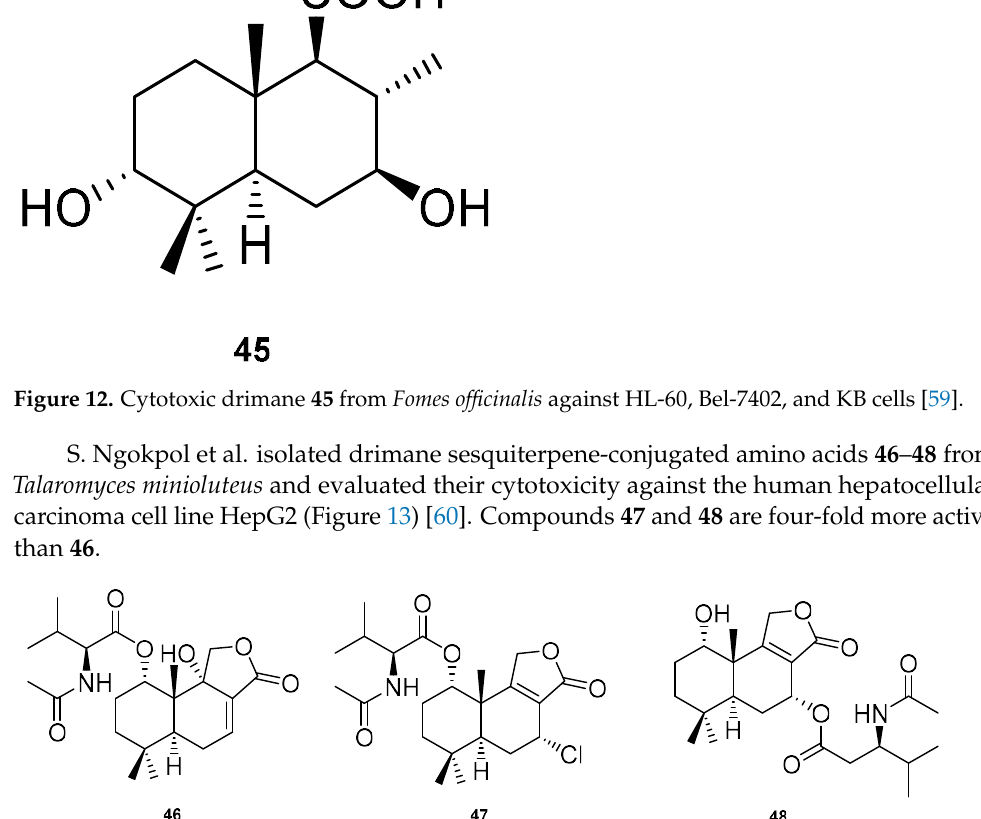
Figure 13. Cytotoxic drimane sesquiterpene-conjugated amino acids from Talaromyces minioluteus [60]. All cytotoxic activities of drimane and coloratane sesquiterpenoids from this subsec- tion are concluded in the following table (Table 1). The compounds are classified by their source and the anticancer activity of each compound refers to certain cell Table 1. Anticancer activity of natural drimane and coloratane sesquiterpenoids 1 . Source Species Comp.